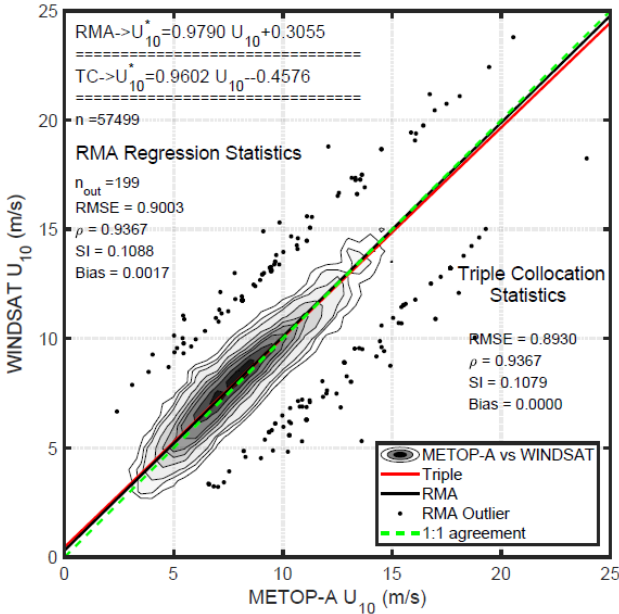
Figure 6. Calibration of METOP-A wind speed with respect to WINDSAT using RMA and triple collocation. The contours represent the normalized density of data points, with contours drawn at 0.9, 0.7, 0.5, …, 0.1, 0.07, 0.04 (maximum value is one). Dots represent outliers excluded from RMA regression using robust regression. 𝑈 10∗ refer to calibrated values of wind speed and 𝑈 10 to uncalibrated values. n and n out are the number of clean (i.e. not outliers) collocated measurements and the number of outliers, respectively. Table 5. Comparison of calibration relations obtained from RMA regression and triple collocation (TC). MA, MB, and WS are abbreviated forms of METOP-A, METOP-B, and WINDSAT, respectively.